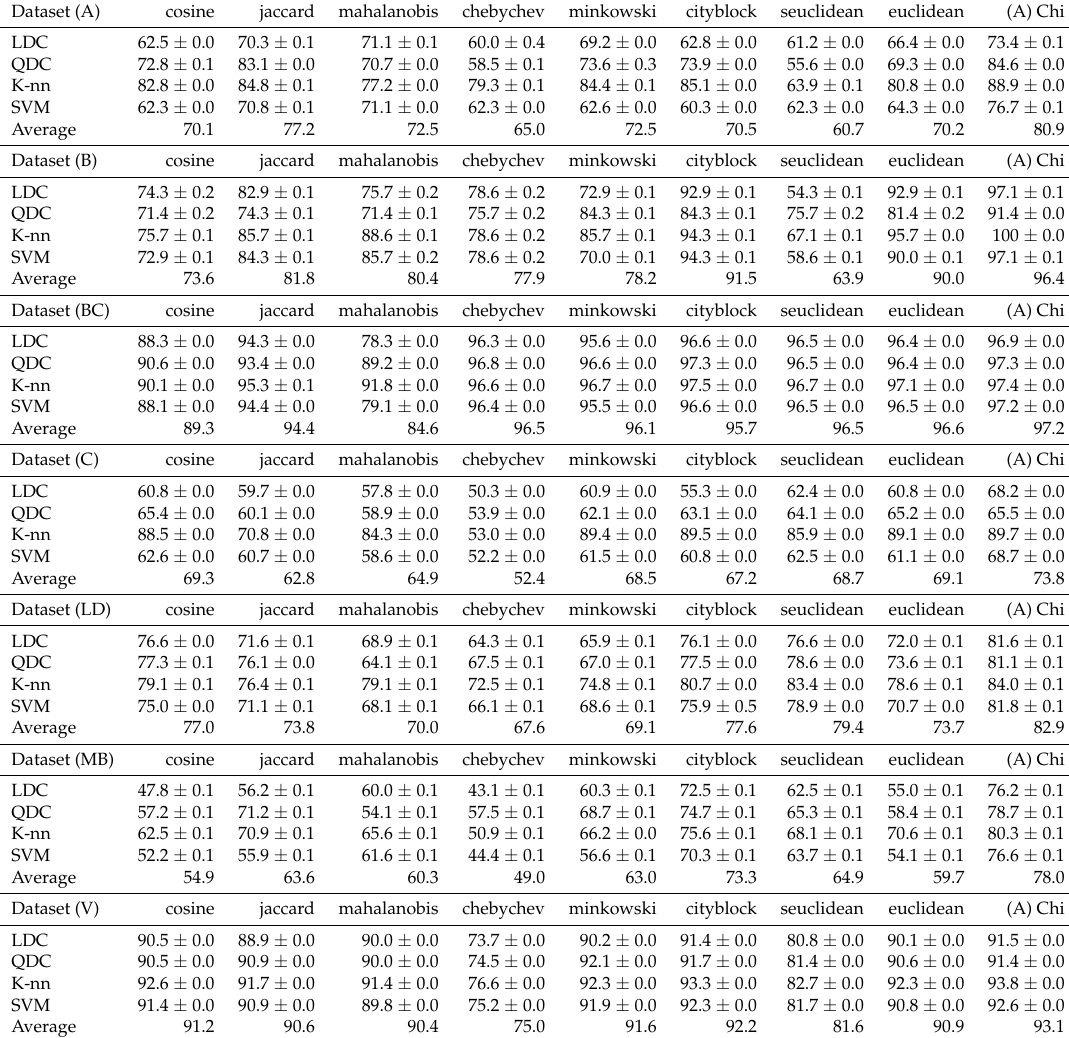
Table 3. Classification results (accuracy) for several distances of the t-SNE algorithm over seven UCI public datasets. LDC and QDC correspond to linear and quadratic Bayesian classifier, K-nn stands for K-nearest neighbor and SVM is the support vector machine. The datasets: A, B, BC, C, LD, MB, V are defined in Table